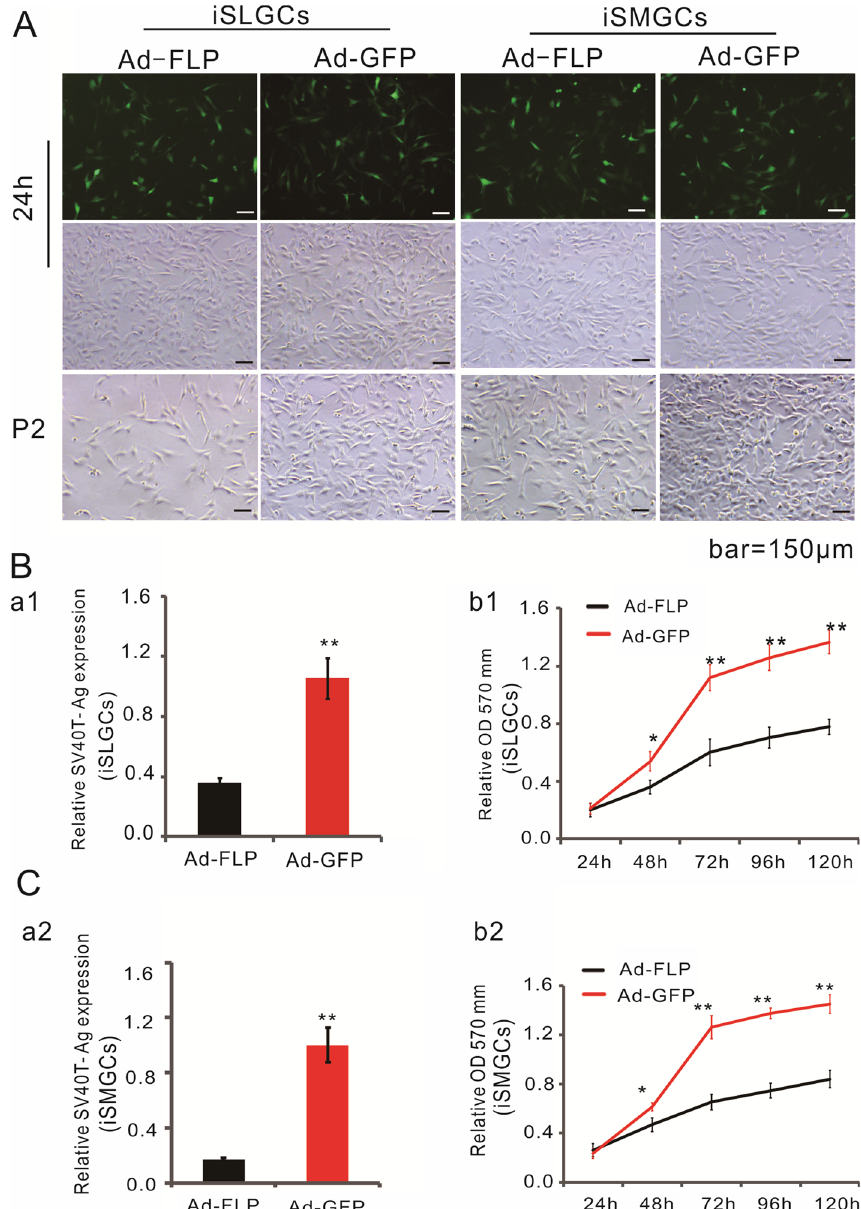
Fig. 4 FLP recombinase-mediated removal of SV40 T antigen decreases proliferative activity of iSMGCs and iSLGCs. A FLP recombinase-mediated removal of SV40 T antigen in iSMGCs or iSLGCs. Cells were infected with Ad-FLP or Ad-GFP as the control. Quantity and intensity of green fluorescent cells was high at 24 h during these treatments. The growth status of Ad-FLP-transduced cells or Ad-GFP-treated cells is shown at passage 2 (p2). B SV40 T-antigen removal efficiency and the effects of multiplication capacity in cells. RT-qPCR confirmed that Ad-FLP decreased SV40 T-antigen expression significantly compared with Ad-GFP treatment. Meanwhile, the multiplication capacity of cells declined and was accompanied by the removal of the SV40 T antigen. Each assay condition was analyzed using a minimum of three independent experiments. * P < 0.05, ** P <